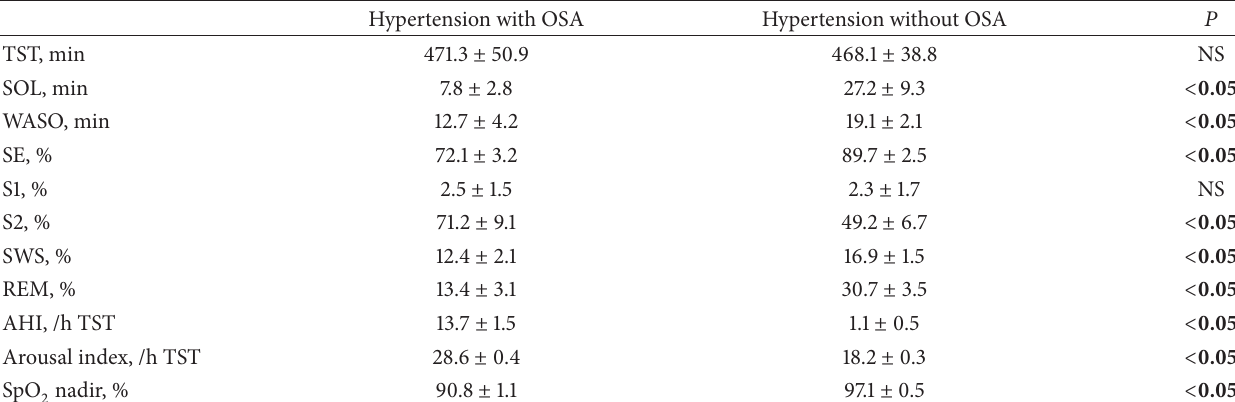
Table 2: Comparison of sleep scoring parameters found in the 2 groups of study subjects.